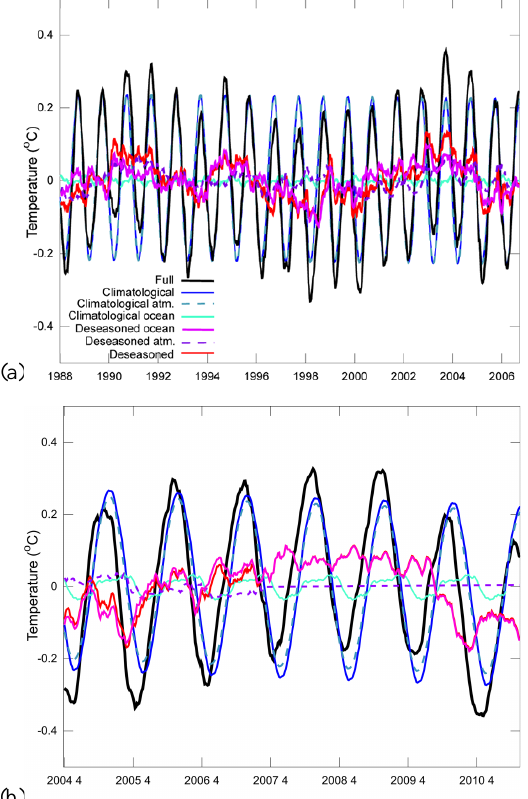
Fig. 7. Figure summarizing the AV (a) and FV (b) box model re- sults, detrended and with the mean removed. Both figures illustrate the OHC variability attributable to the tested forcing scenarios. Note the atmospheric dominance on the seasonally varying climatology (referred to as “climatological”) OHC variability, and the oceanic dominance of the deseasoned OHC variability. Panel (b) starts in April 2004, as this is when the RAPID-based estimates become